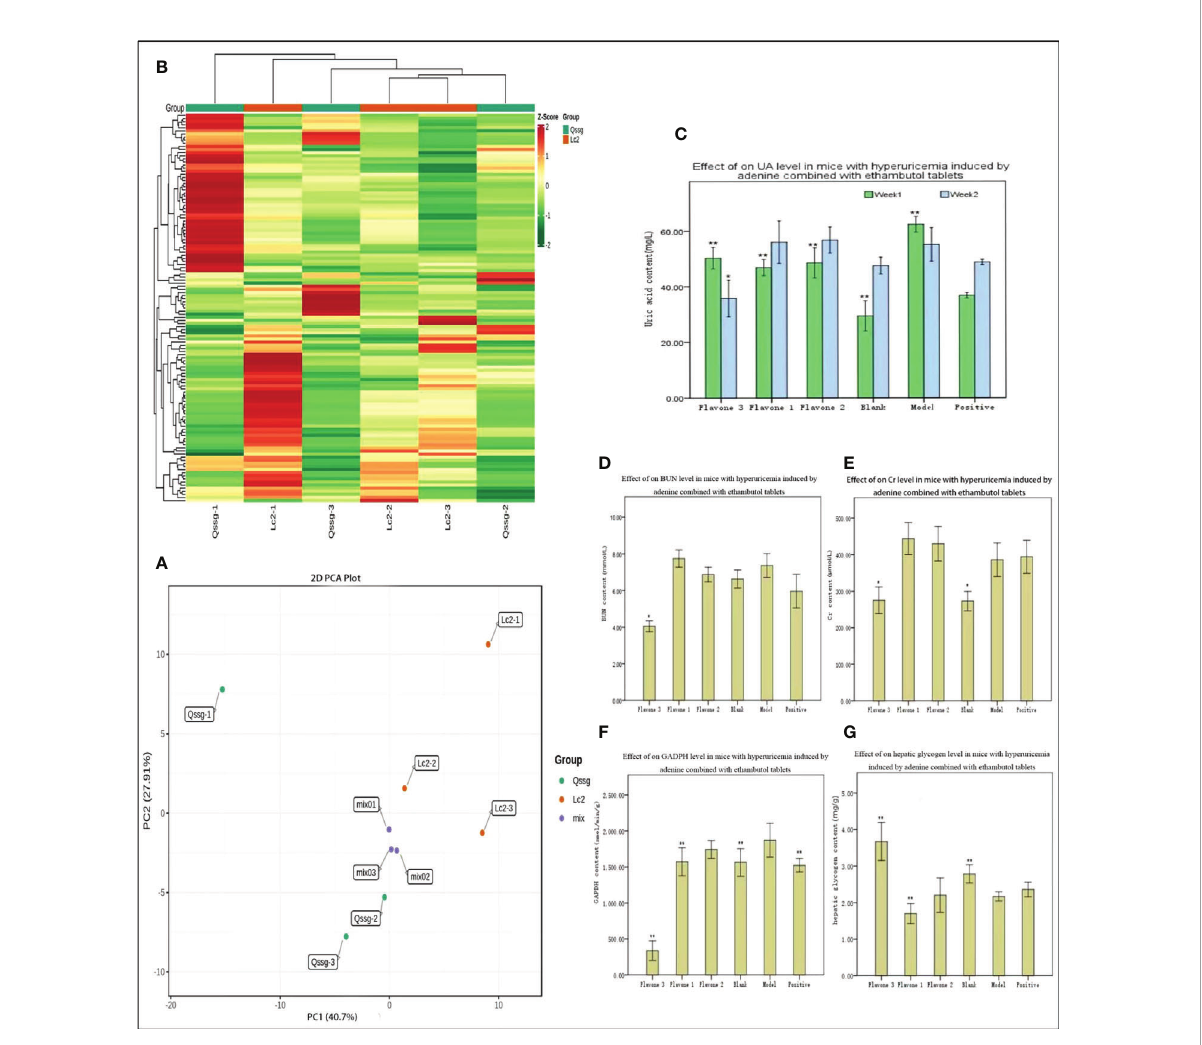
FIGURE 2 Composition of fl avonoids and uric acid reducing analysis results in Qssg and Lc Actinidia agruta Sieb.Zucc . (A) PCA score map of metabolites in Qssg and Lc fruits, each point representing an independent biological repeat. (B) Clustering heat map of metabolites in Qssg and Lc fruits. There are obvious differences between the two samples. (C) Effect of adenine combined with UA levels in mice with hyperuricemia. (D) Effect of adenine combined with ethambutol tablets and acetaminophen on BUN levels in mice with hyperuricemia. (E) Effect of adenine combined with ethambutol tablets and acetaminophen on Cr levels in mice with hyperuricemia. (F) Effect of adenine combined with ethambutol GAPDH levels in mice with hyperuricemia. (G) Effect of adenine combined with tablets and acetaminophen on hepatic glycogen levels in mice with hyperuricemia. "*" Indicates signi fi cant, “ ** ” indicates extremely signi fi